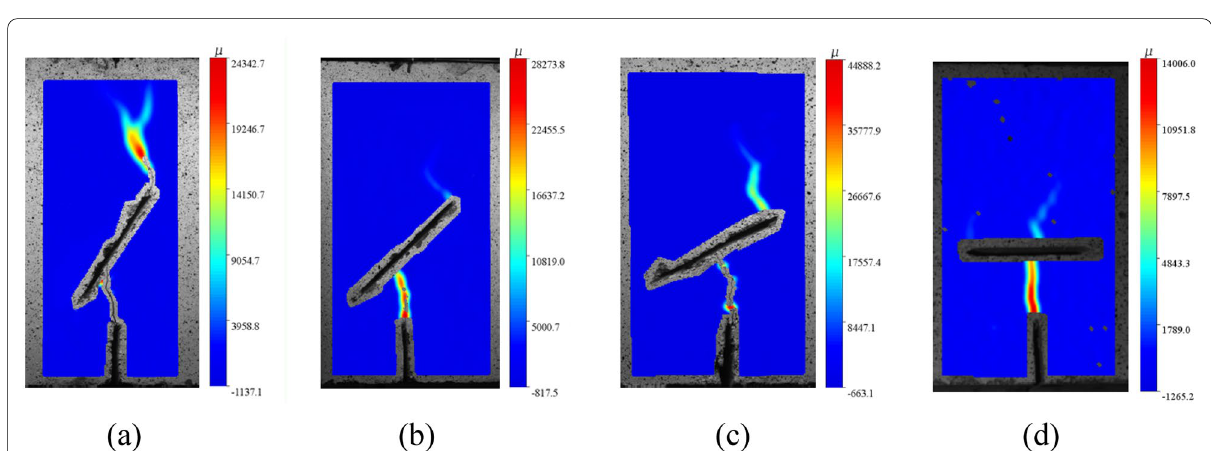
30°, ( b ) θ 45°, ( c ) θ 60°, and ( d ) θ 90° at the loading rate of 10 –3 mm/s = = = =